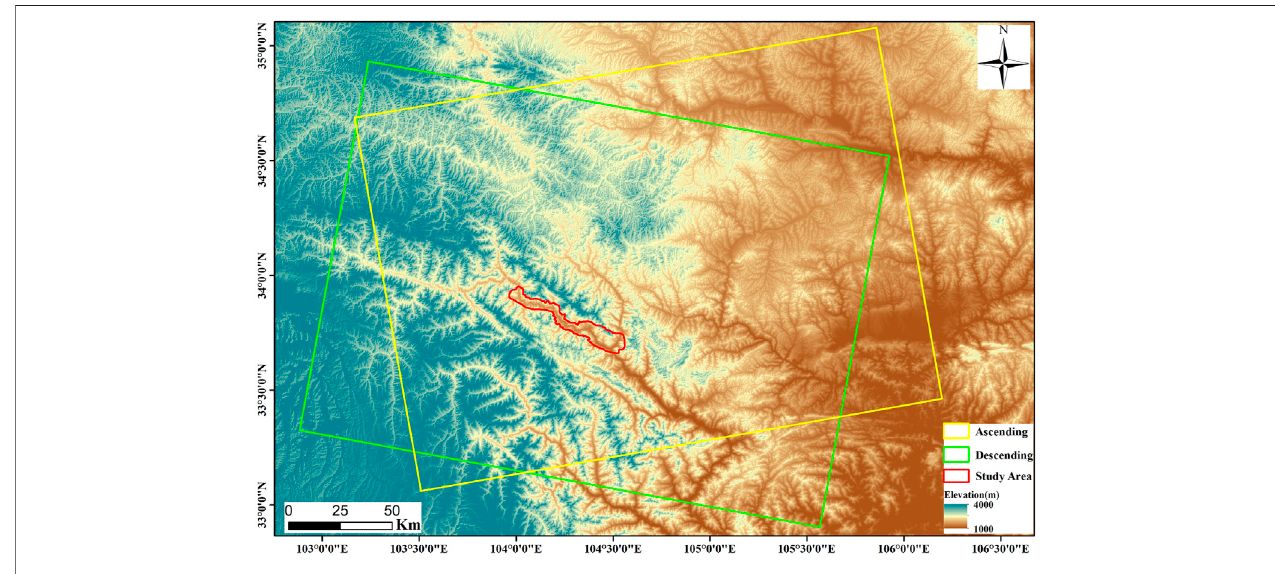
FIGURE 2 | The spatial coverage of the images used in the study.